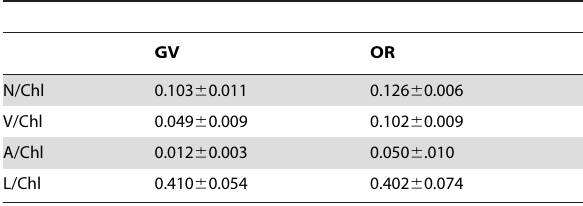
Table 1. Quantitative analysis of pigments adhered to native thylakoid membranes.